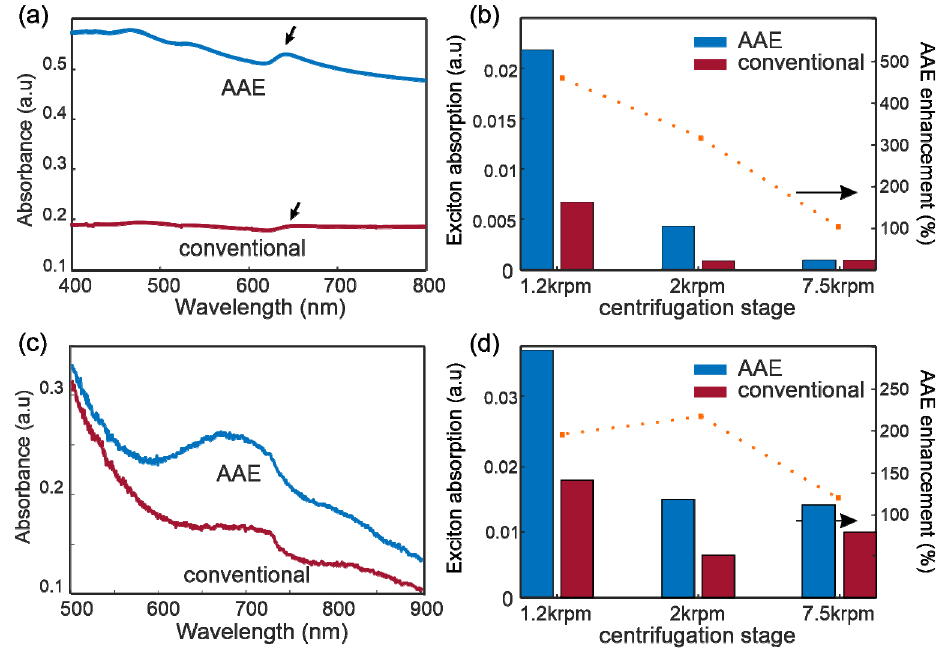
Figure 3. Spectroscopic evidence of AAE enhancement: ( a ), UV-vis spectra of exfoliated WS 2 solutions produced from AAE and conventional shear exfoliation, with arrows indicating A-exciton peak ( b ) exciton absorption of WS 2 samples produced from AAE and conventional shear exfoliation (columns) and AAE improvement (dotted line), ( c ) UV-Vis spectra of MoS 2 solution for AAE and conventional exfoliation, ( d ) exciton absorption of MoS2 and AAE improvement.